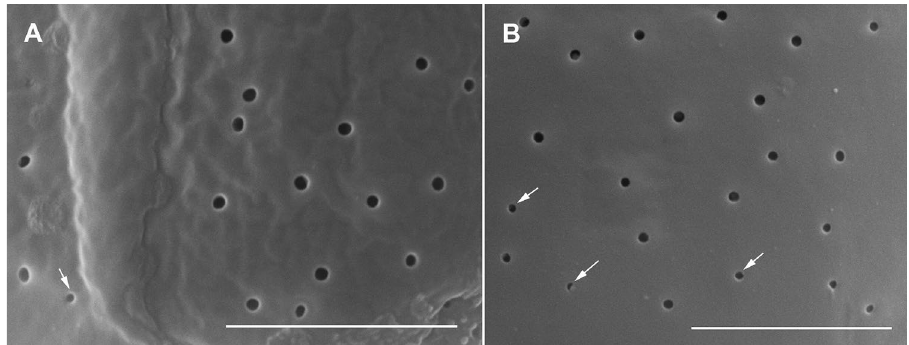
Figure 11. Scanning electron micrographs of Coolia malayensis strain C6C1 showing the thecal pores. ( A ) Recognize the plate overlap area without pores. ( B ) Large and slightly smaller (arrows) pores are visible. Scale bars = 5 µm.